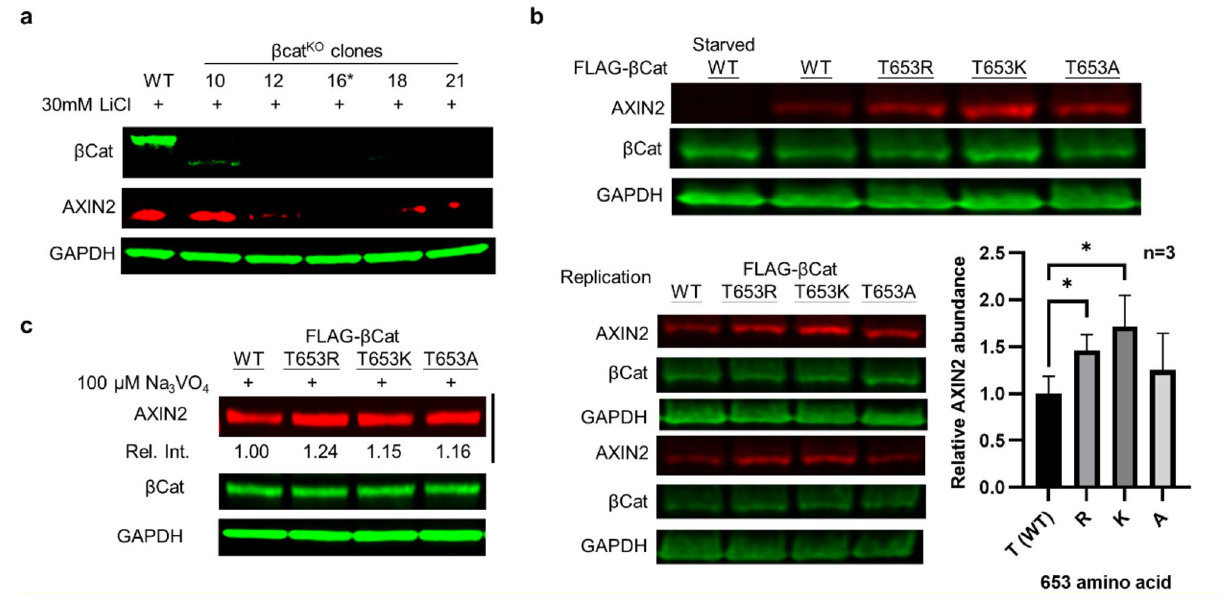
Figure 4. β-cat T653 basic charge mutants display enhanced Wnt-signaling. ( a ) HEK β-cat KO cells generated with CRISPR-Cas9 displays a lower AXIN2 expression level treated with LiCl. Clone 16 was used for the studies. ( b ) In biological triplicate experiments, T653R and T653K β-cats induce more AXIN2 protein expression than WT β-cat. Error bars: one standard deviation. *: p < 0.05 in t-test. ( c ) PTP inhibition with pervanadate (100 μM) eliminates differences in AXIN2 levels between WT and mutant